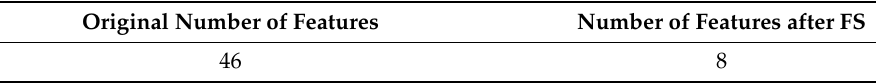
Figure 8. Confusion matrix of kNN-FS. As can be seen in the confusion matrix of kNN-FS, the DDoS class has 6643 pieces of data that are predicted correctly, with only one piece of data incorrectly predicted. The Reconnaissance class has 5047 pieces of data correctly predicted while two others had a different class. Similarly, the DoS class has 6808 pieces of data correctly predicted and seven pieces of data with an incorrect class. Then, there are 473 pieces of data predicted correctly in the